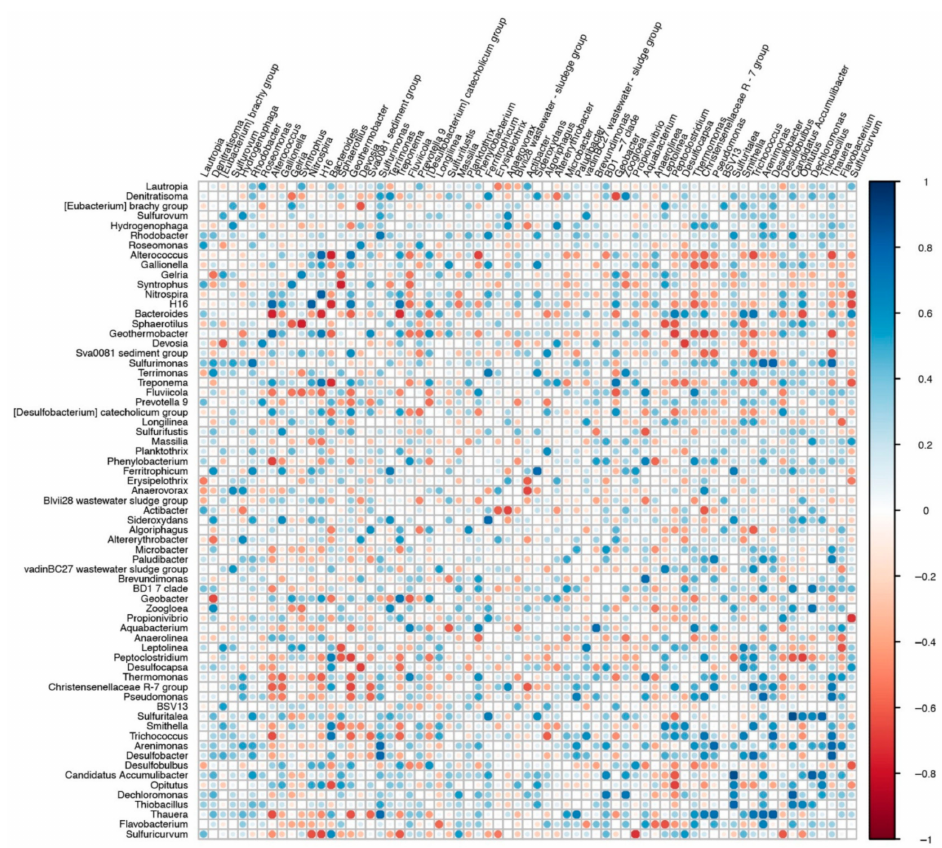
Figure 3. Pearson co-correlation plot (2%) showing taxa dynamics (inhibition or induction effects) induced by taxa